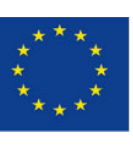
Figure 12. Total battery cell weight for the monotype and cost ‐ optimal HESS.